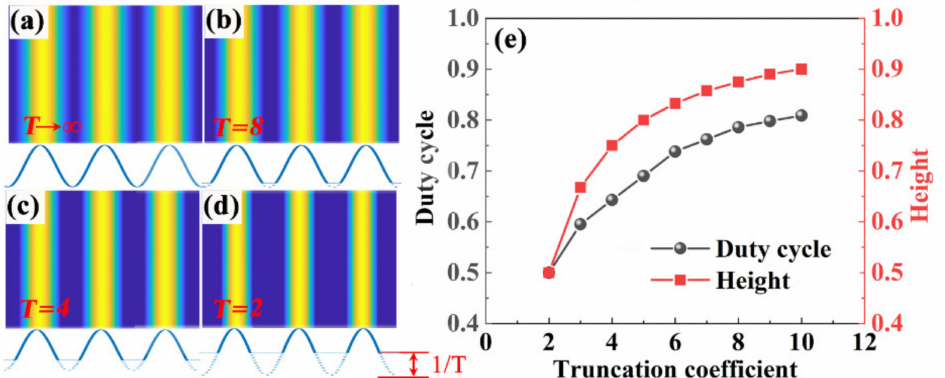
Figure 3. Simulated grating structures for different exposure times. The insets indicate the cross- sectional profiles of corresponding gratings. ( a ) T is ∞ . ( b ) T is 10. ( c ) T is 4. ( d ) T is 2. ( e ) Duty cycle and height of the grating as a function of the truncation